Question: Sum up the contents of this chart in one sentence.
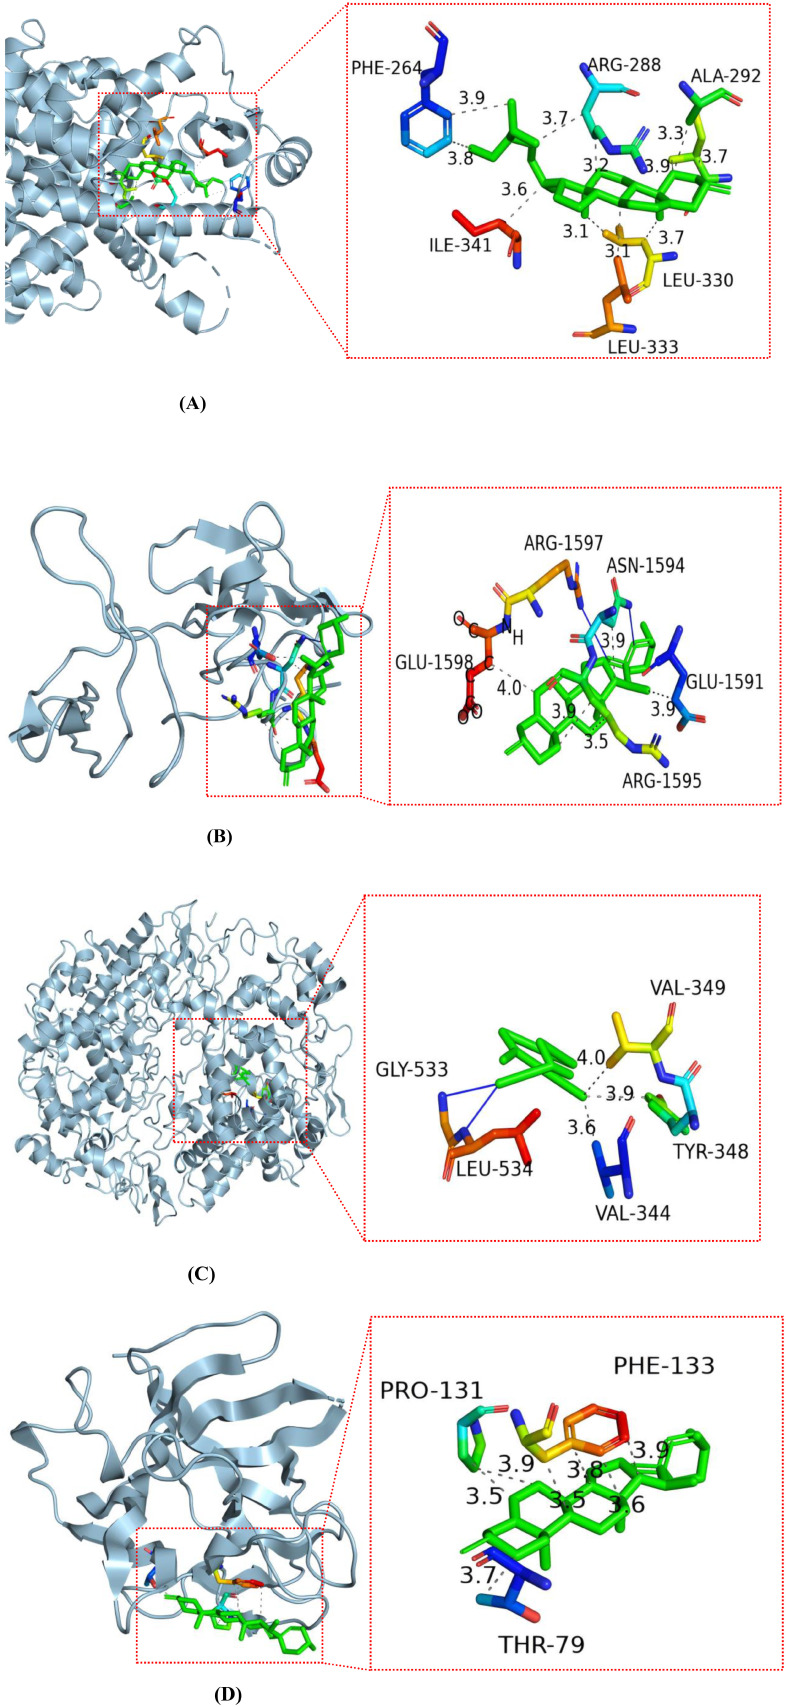
Answer: Molecular docking results (Tufuling). (A) Molecular docking of PPARG with beta-sitosterol. (B) Molecular docking of TP35 with diosgenim. (C) Docking plot of PTGS2 with diosgenim molecule. (C) Docking pf PTGS2 with diosgenim molecule. (D) Docking of IL1B with diosgenim molecule.